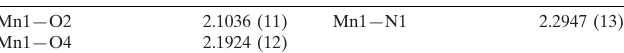
Selected bond lengths (A˚ ).